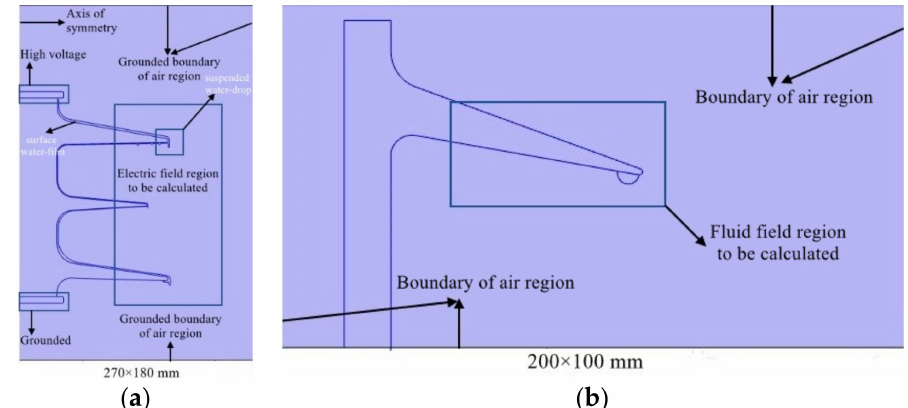
Figure 3. Simulation model of the insulator with the suspended water-drop. ( a ) 2D electric field simulation model: overall view; ( b ) solid–fluid coupling simulation model: partial